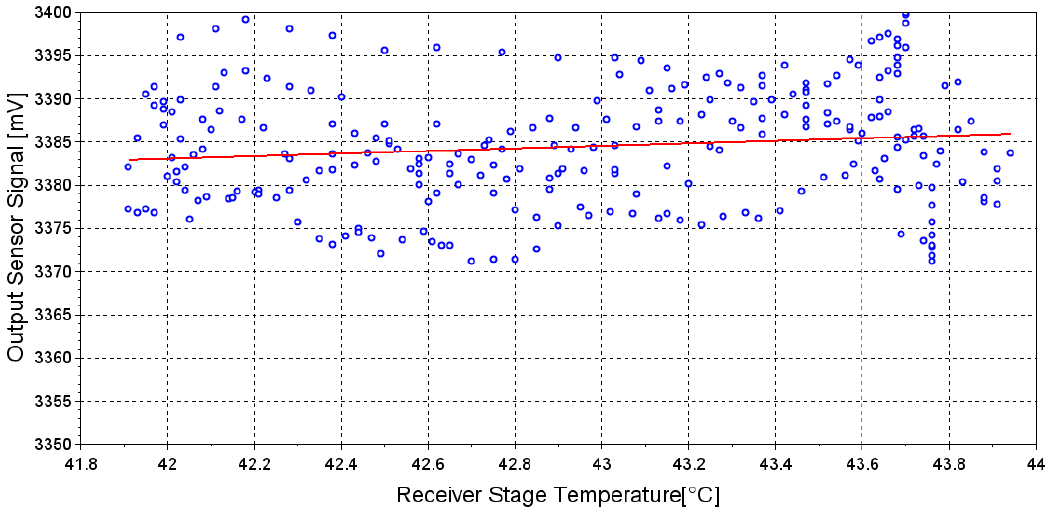
Figure 10. Experimental evaluation of correlation between emitted output power and receiver stage temperature. Blue dots represent the sampled value of the output sensor voltage at several temperatures of the receiver stage. Red line represents the linear regression of the